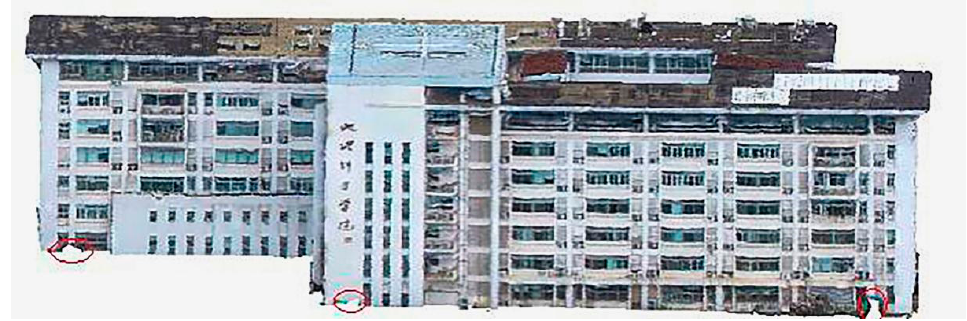
Figure 6. Building point cloud with holes (red circles represent the location of holes).